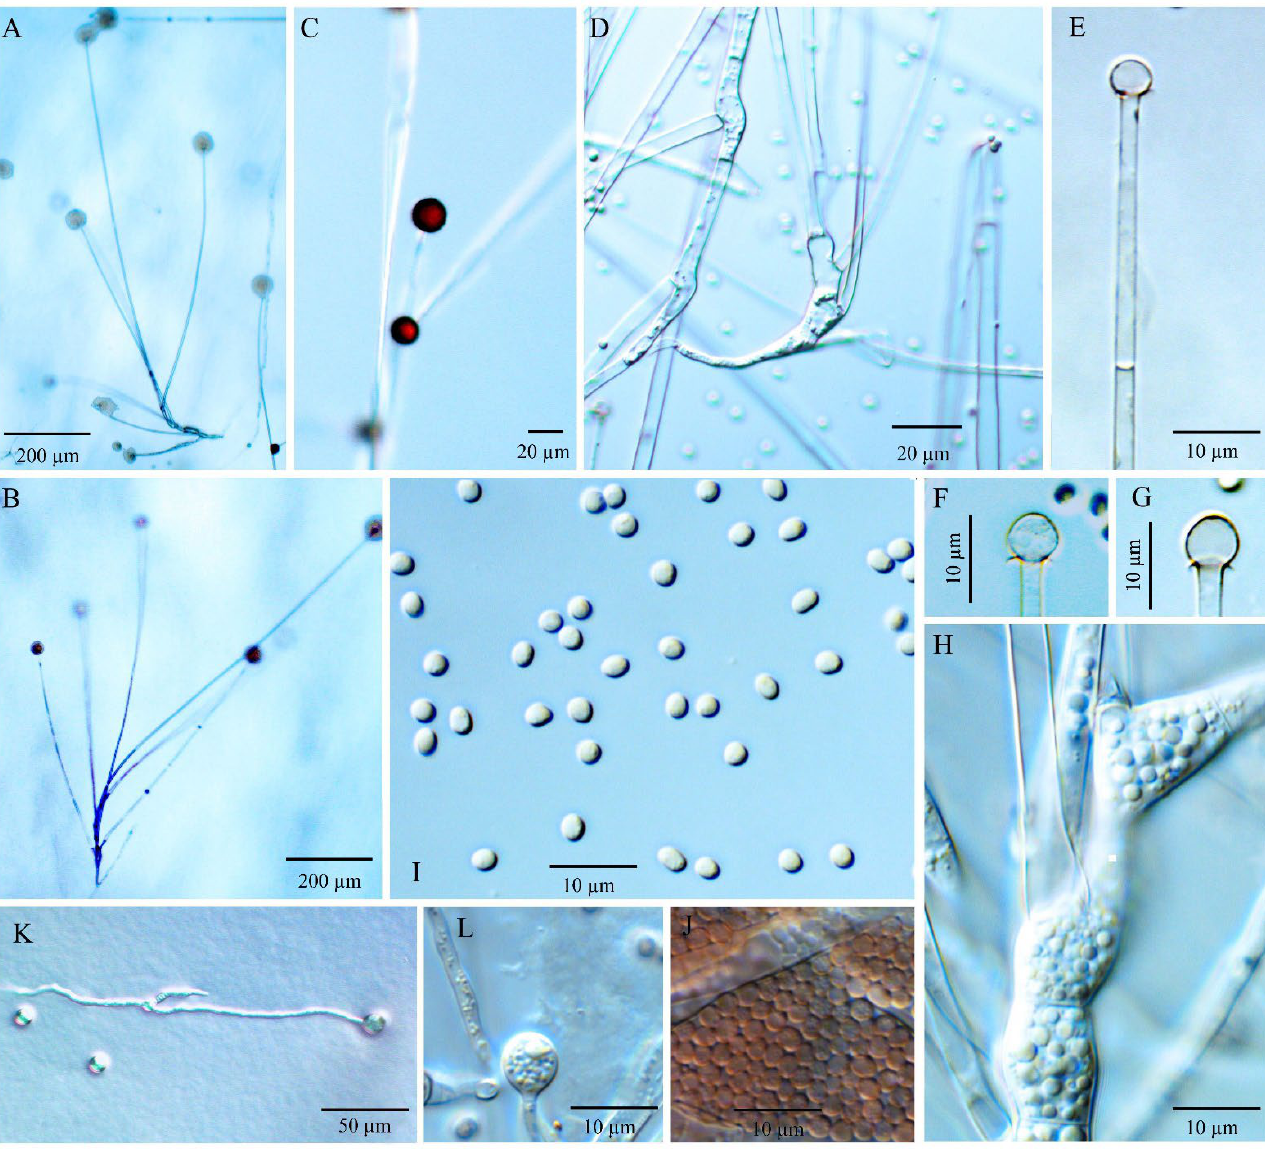
Figure 5. Umbelopsis microsporangia . ( A , B ) Branched sporangiophores. ( C ) Sporangium at tip of sporangiophore. ( D , H ) Branch point of sporangiophore. ( E – G ) Various shapes of collars and colu- mellae at sporangiophore tips after the sporangia have been dissolved. ( I , J ) Sporangiospores. ( K , L ) Micro-chlamydospores.